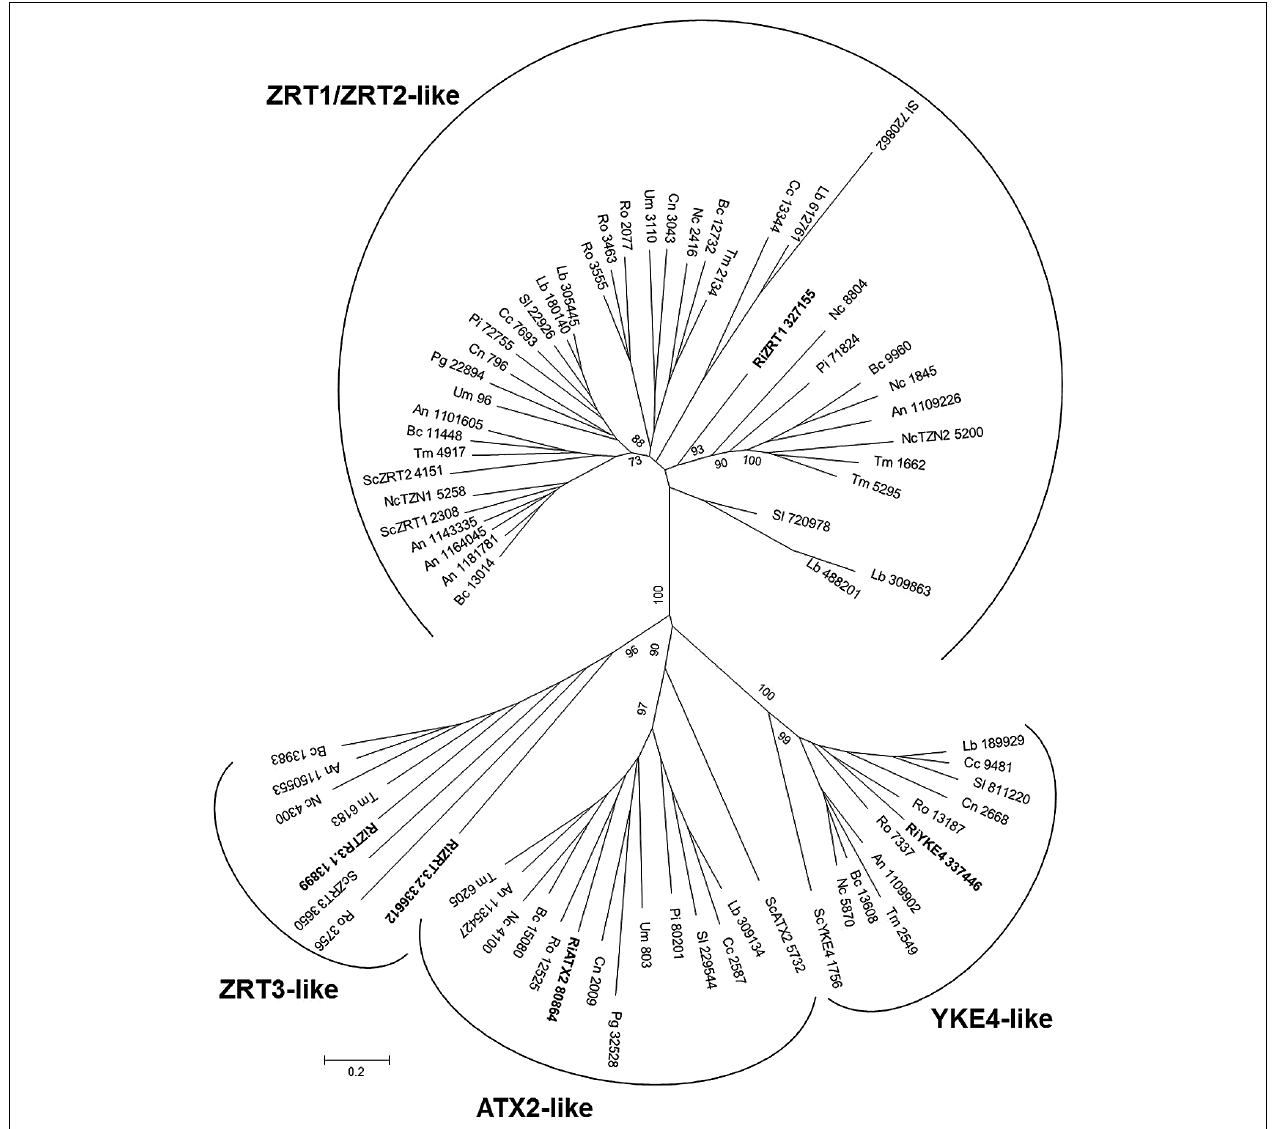
FIGURE 6 | Phylogenetic relationships of the Rhizophagus irregularis zinc-iron permeases (ZIPs) with homologous sequences from selected species representative of the major fungal phyla. The Neighbor-Joining tree was created with MEGA 6. Protein JGI identification numbers are indicated. R. irregularis genes are shown in bold. Organisms: An, Aspergillus niger ; Bc, Botrytis cinerea ;